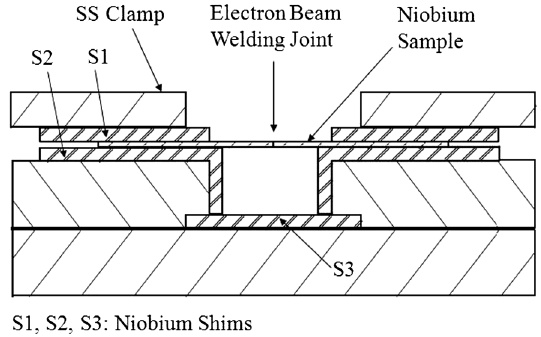
FIG. 3. Cross section of the fixture used for preparing the electron beam welded niobium samples.